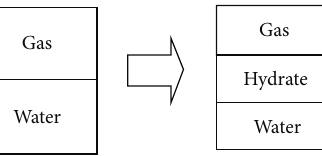
Figure 3: Chart of hydrate